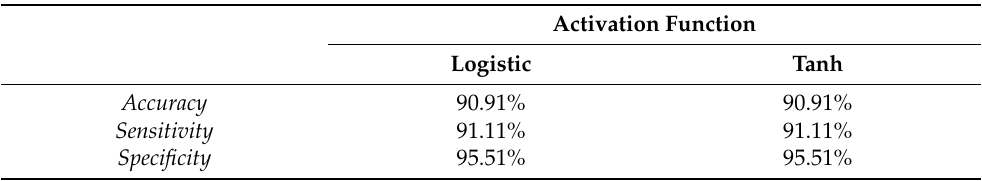
Table 9. Performance measurements of the proposed predictive ANN